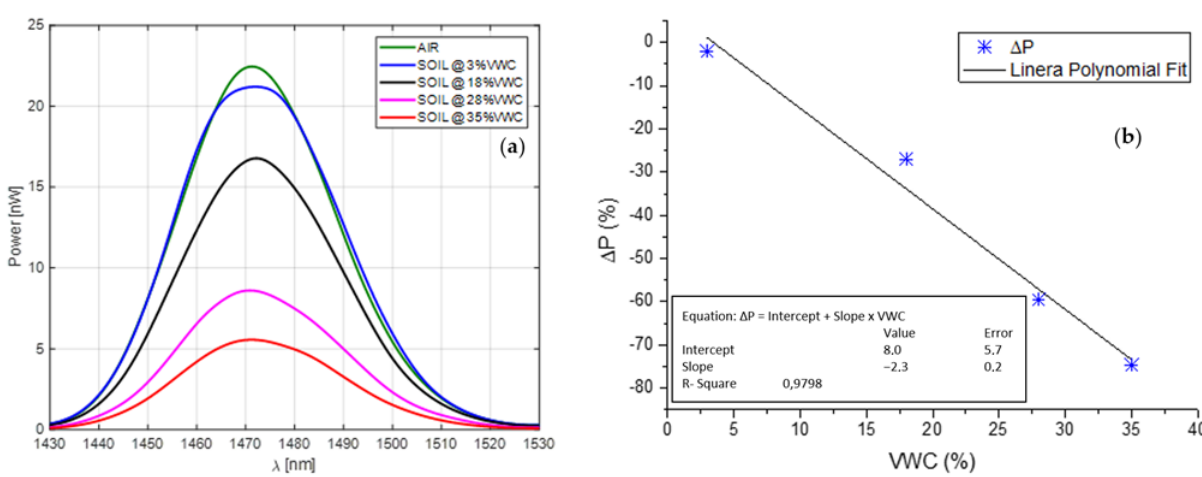
Figure 7. ( a ) Reflected spectra; ( b ) Characteristic curve ( ∆ P vs. VWC) where ∆ P is defined as the reflected power variation at 1470 nm normalized with respect to the initial maximum power. Reprinted with permission from Elsevier from Ref. [59] (the figure is released under a Copyright Clearance Center’s RightsLink ® service, Copyright © 2022).